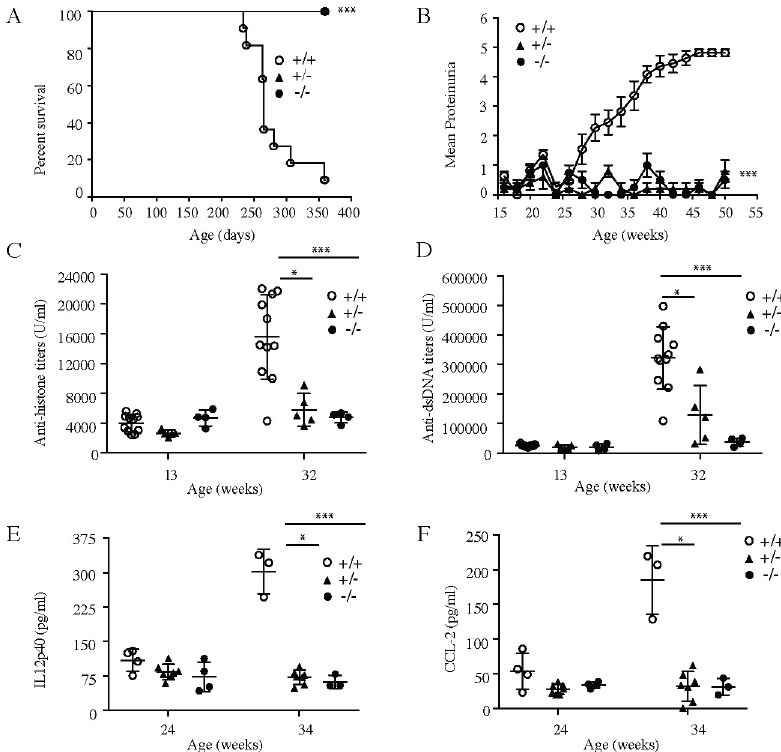
Fig 4. Lack of SLC15A4 protects mice from developing spontaneous lupus phenotype in NZB/W F1 mice. NZB/W F1 slc15a4 +/+ , slc15a4 +/- , and slc15a4 -/- mice were enrolled at an age of 13 weeks and monitored every two weeks. Survival (A) and proteinuria (B) were monitored throughout the study. Serum was evaluated at indicated times for the presence of anti-dsDNA antibodies (C), anti-histone antibodies (D), IL12p40 (E), and CCL-2 (F). Comparisons were made between wildtype group and knockouts or heterozygous groups � p < 0.05, �� p < 0.005, ��� p < 0.0005, N = 4–10 mice per